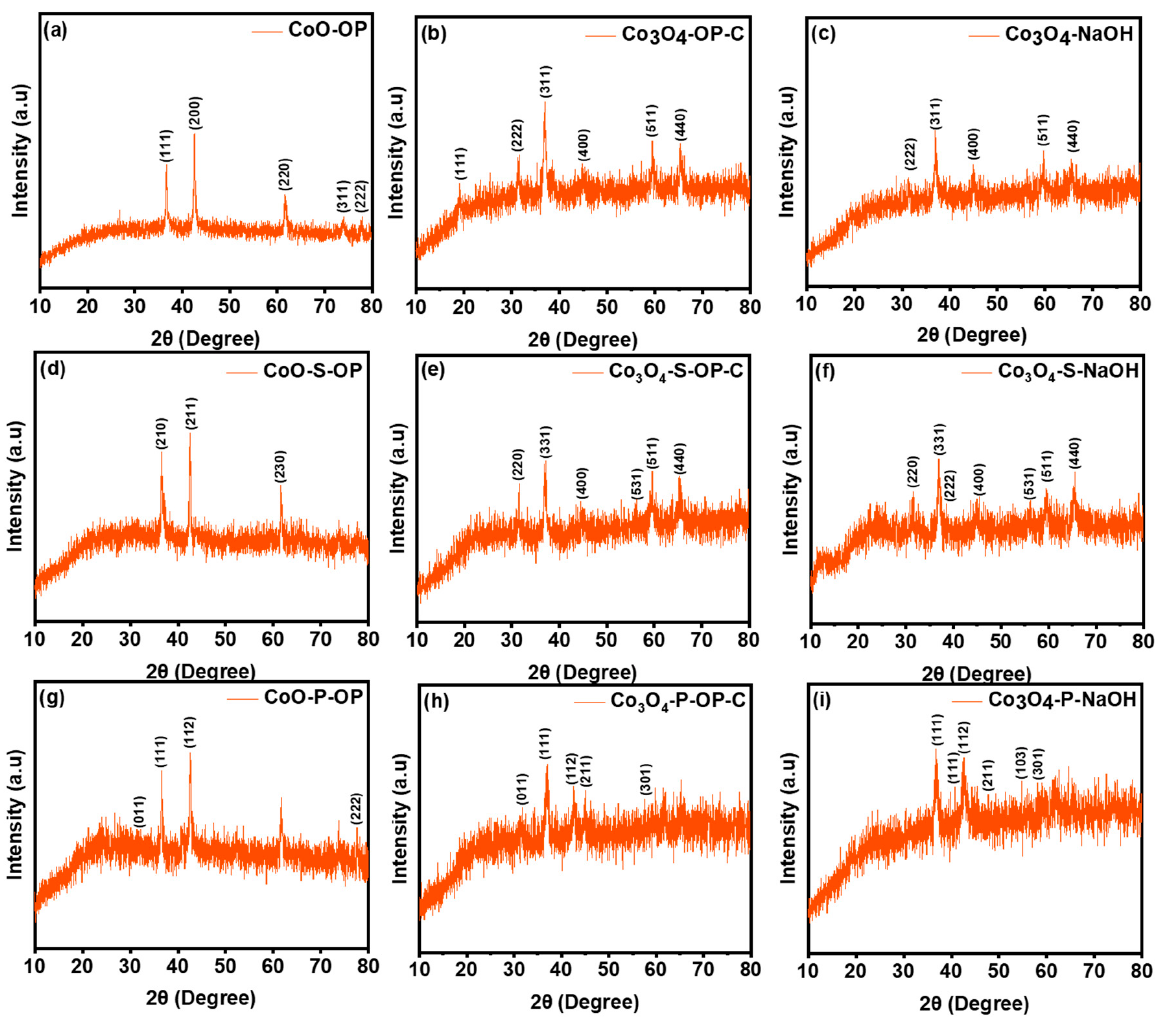
Figure 3. X-Ray diffraction patterns of the prepared ( a ) CoO-OP, ( b ) Co 3 O 4 -OP-C, ( c ) Co 3 O 4 -NaOH, ( d ) Co 3 O 4 -S-OP, ( e ) Co 3 O 4 -S-OP-C, ( f ) Co 3 O 4 -S-NaOH, ( g ) CoO-P-OP, ( h ) Co 3 O 4 -P-OP-C, ( i ) Co 3 O 4 - P-NaOH, nanoparticles.